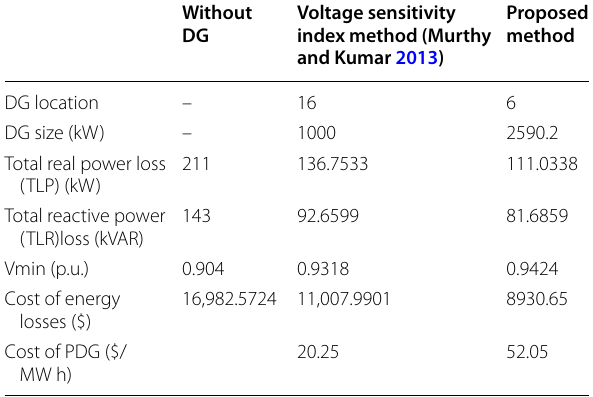
Table 8 Results for 69 bus system with DG at 0.9